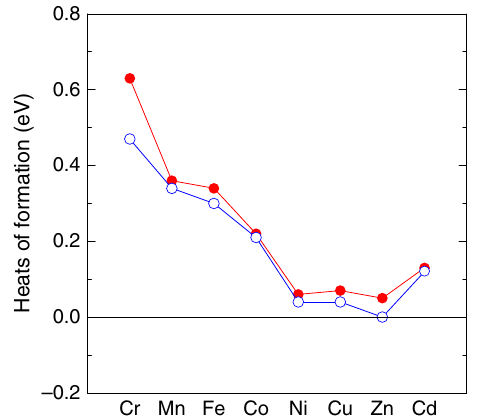
Figure 5 | Calculated heats of formation per formula unit in M 0.25 T 2 PTe 2 ( T ¼ Ti, Zr). The heat of formation was defined as E f ¼ E (1T- M 0.25 T 2 PTe 2 ) (cid:4) E (3R- T 2 PTe 2 ) (cid:4) 0.25 E ( M ), where T ¼ Ti (red) and